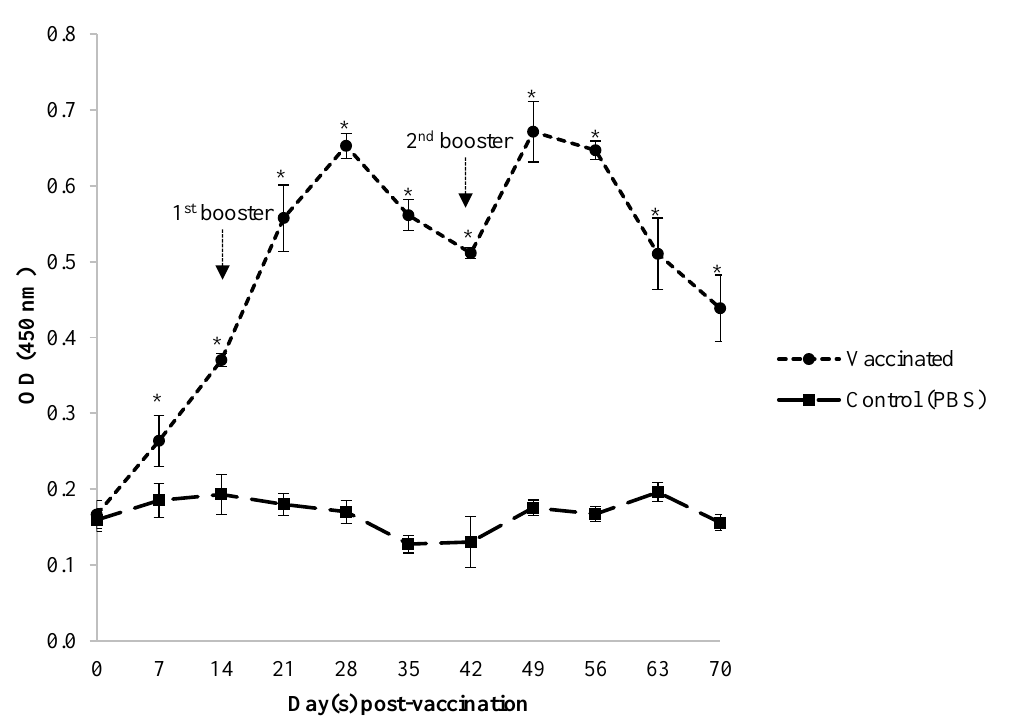
Figure 3. Antibody level of specific IgM in serum against Vibrio parahaemolyticus strain VPK1 in Asian seabass, Lates calca- rifer following oral vaccination with Vibrio harveyi strain VH1. Data are the mean ± SD from 6 fish per group at each time point. Asterisks stand for statistically significant differences ( p < 0.05) between groups.